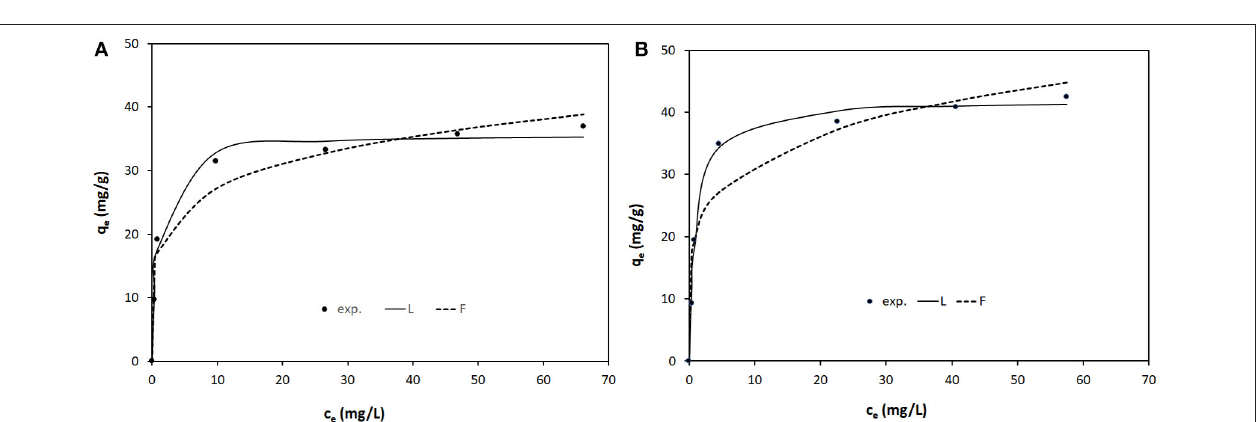
FIGURE 6 | Equilibrium isotherms of Orange II adsorption onto: (A) LDH-R and (B) LDH-W at 293K.